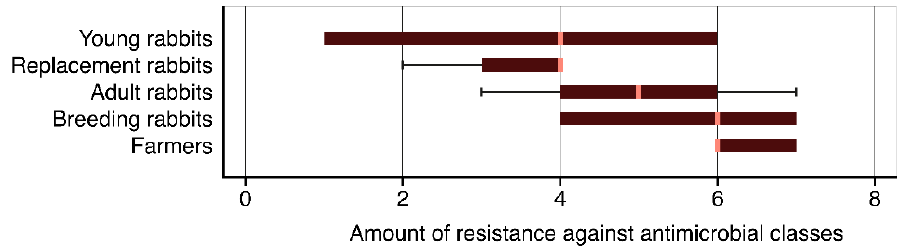
Figure 4. Resistance against antimicrobial classes for rabbits (age categories) and farmers. Legend: Error bars = Inter-quartile range.